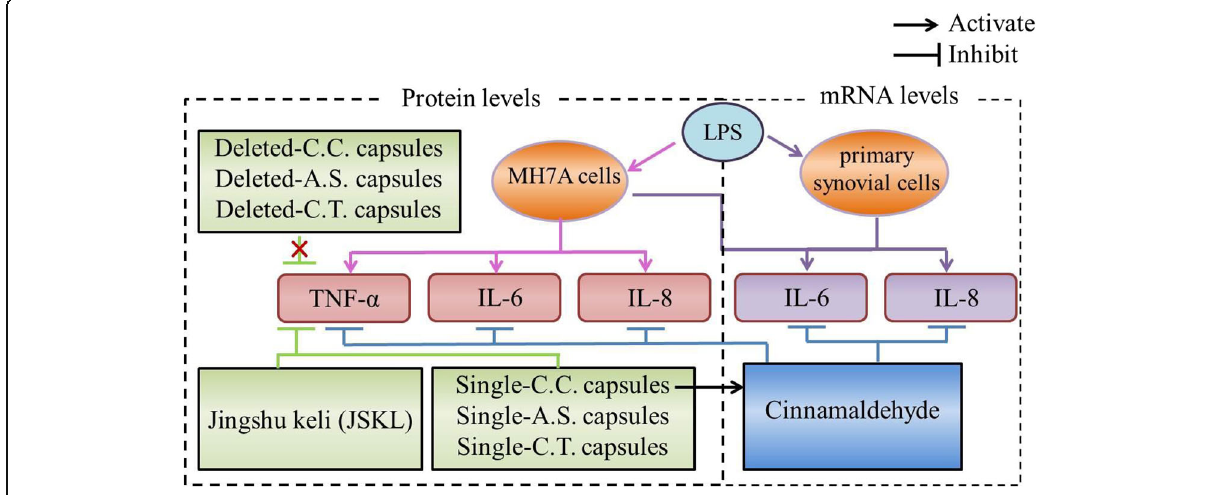
Fig. 1 Schematic illustration of evaluation of the anti-inflammatory effects of JSKL and its components in